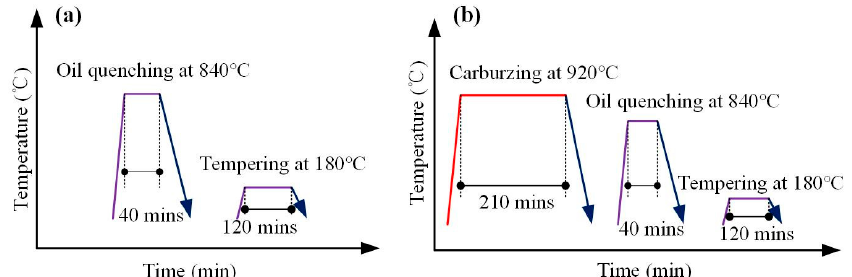
Figure 2. The diagram of heat treatment process for 20CrMnTi steel: ( a ) quenching, ( b ) carburizing.